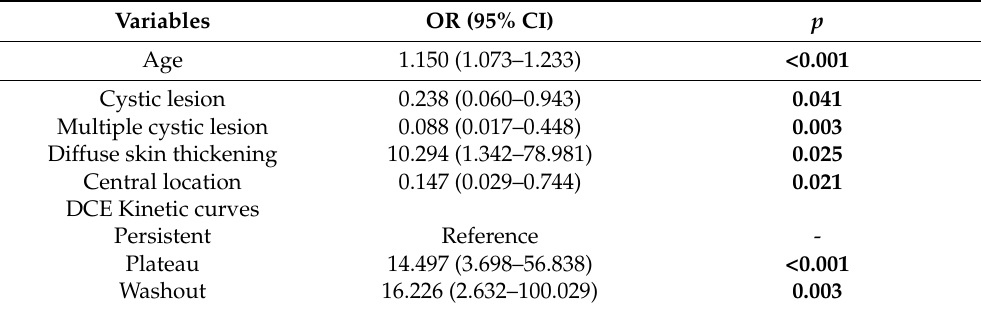
Table 6. A backward stepwise multivariate logistic regression analysis to determine associated factors with